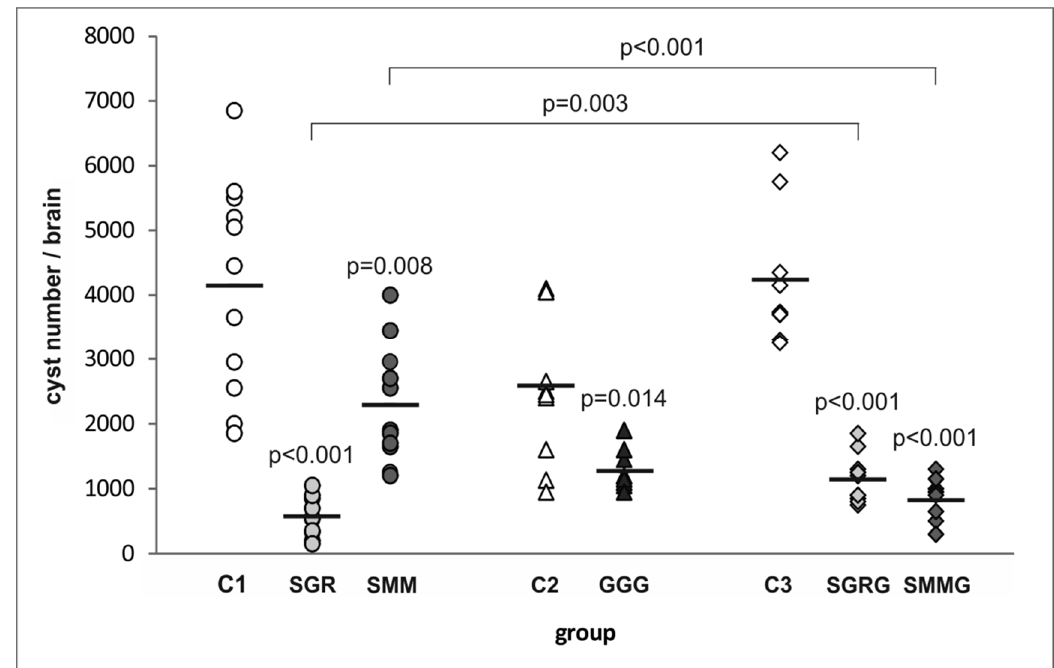
Figure 3. Cyst burden in the immunized and control mice challenged with T. gondii . p -values for statistically significant differences in brain cyst load of mice immunized with chimeric T. gondii recombinant antigens compared to their respective controls (C1, C2, C3), non-immunized mice, are given above the dots; statistically significant differences between groups immunized with trivalent antigens and their tetravalent counterparts are marked with brackets; bars represent the mean cyst numbers in experimental groups.